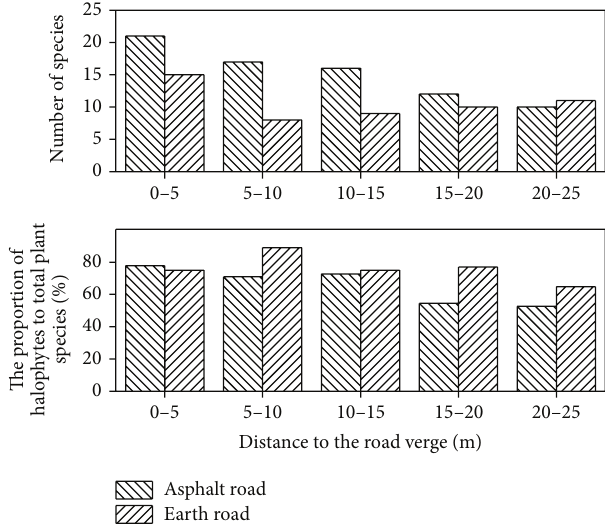
Figure 4: Number and proportion of halophytes in plots of asphalt roadsides and earth